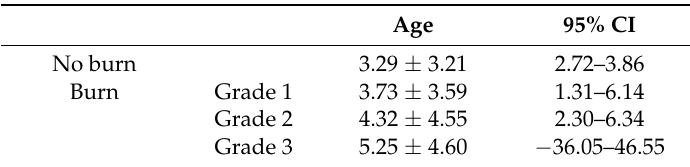
Table 1. The mean age of the patients per burn